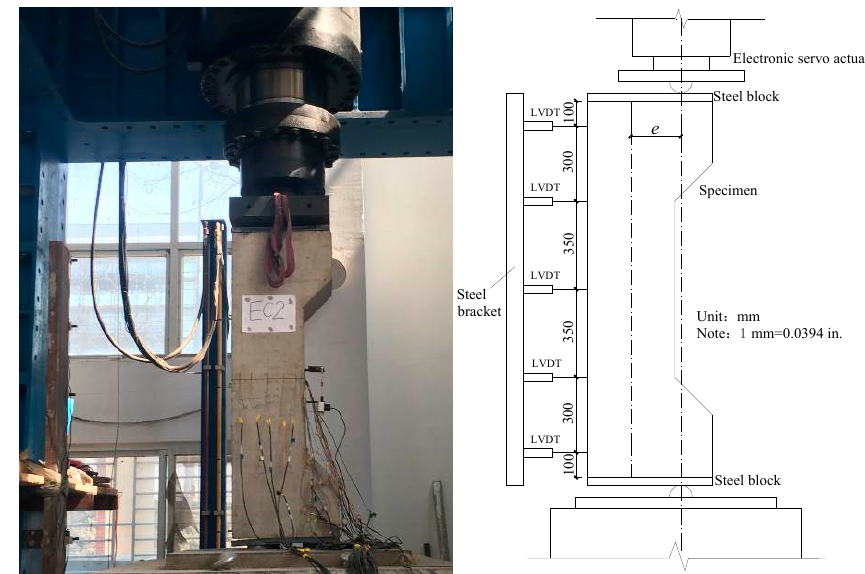
Figure 3. Typical test setup and instrumentation.